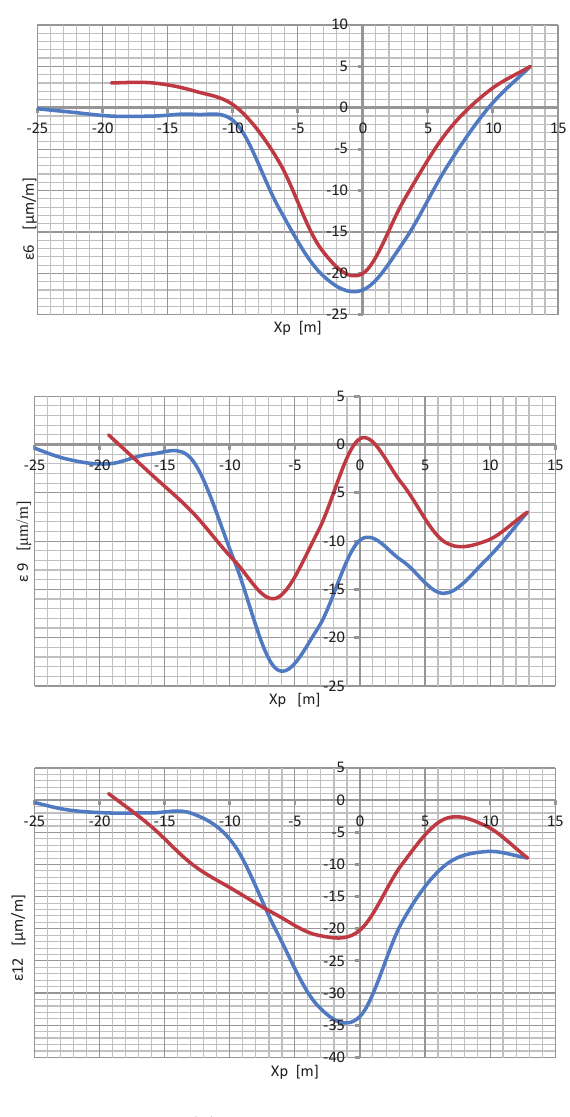
( x ) for three points in the shell crown D p